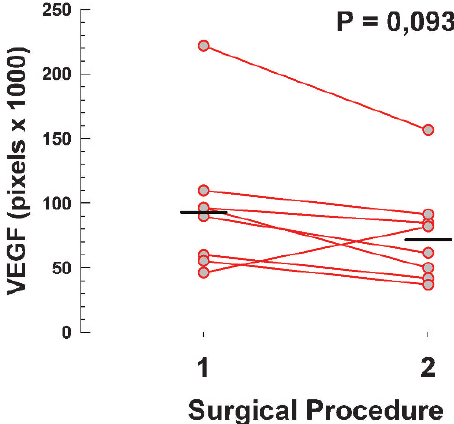
Figure 6 - Scoter plot with lines showing the variation of the VEGF between surgical procedure 1 and 2. Short thick lines represent the series median values.